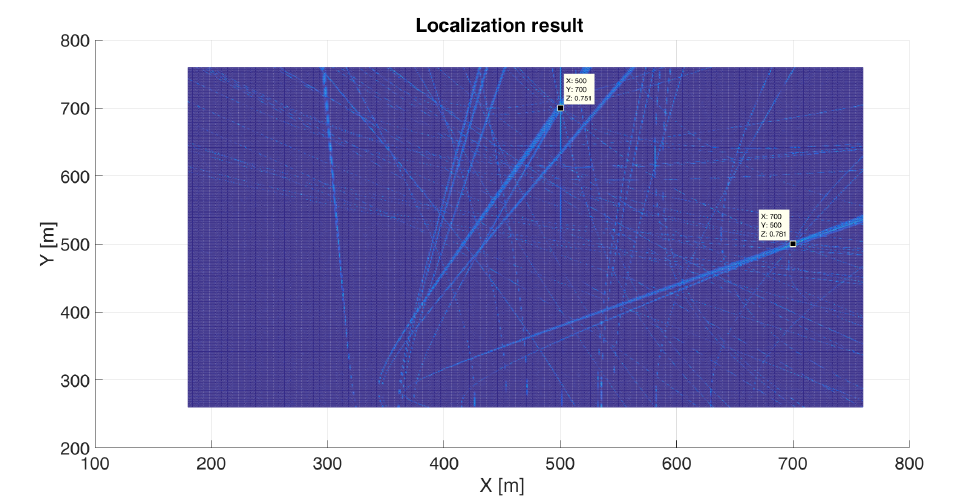
Figure 12. The localization results of the 10-th and 4-th source, i.e., the 8-th impulse in the reference channel—2D